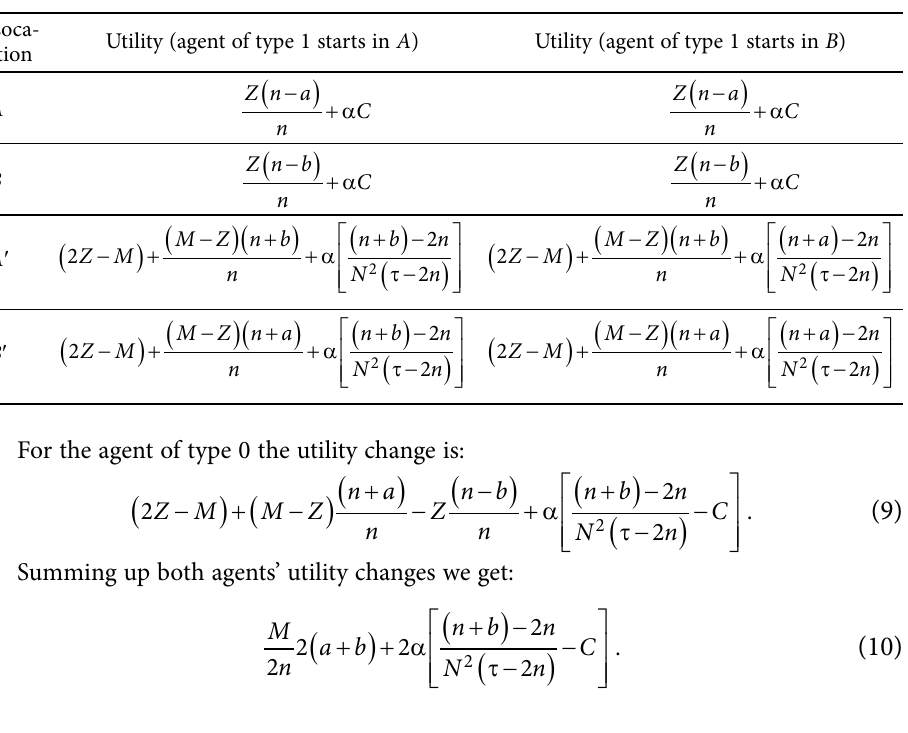
Table 1. Type 1 interchange utility variation Loca- Utility (agent of type 1 starts in A ) Utility (agent of type 1 starts in B ) tion